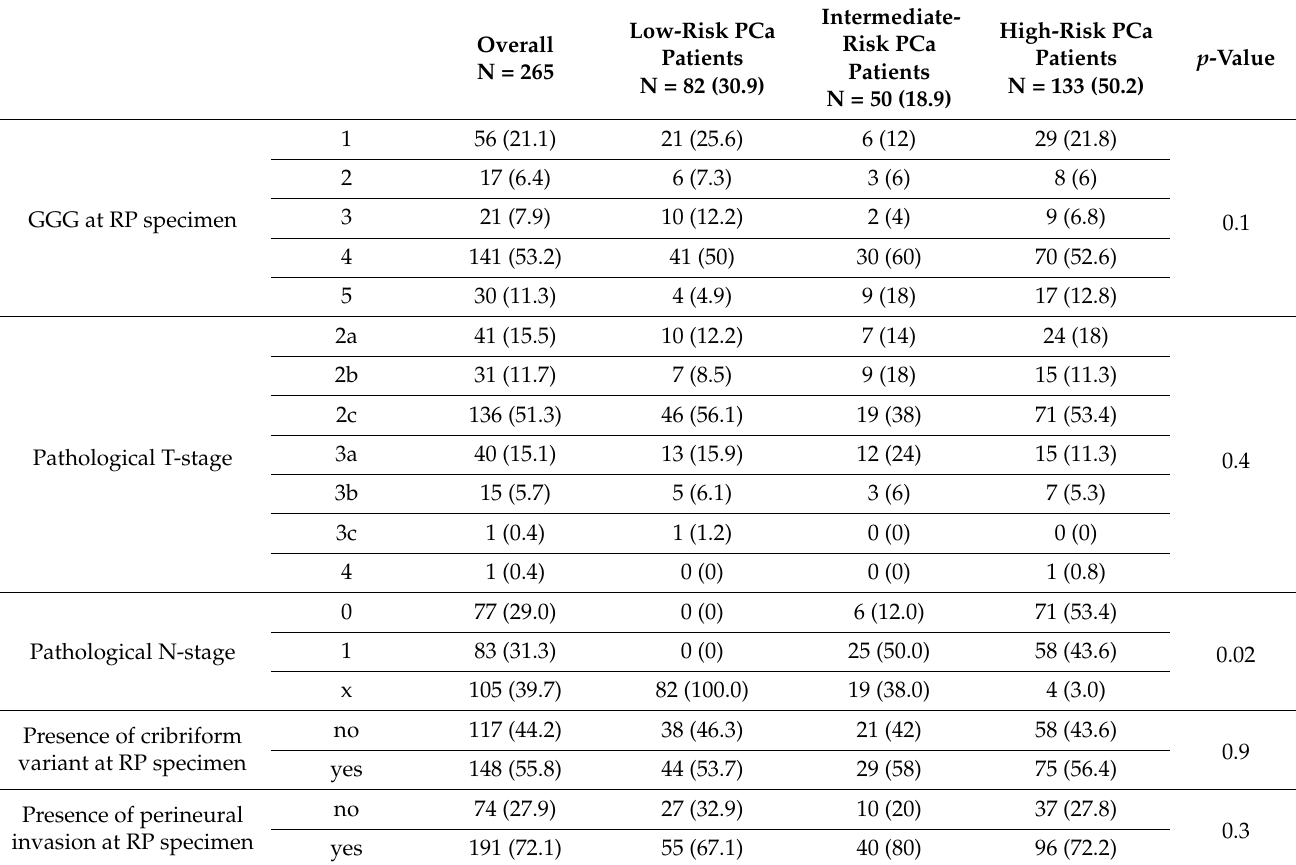
Table 2. Tumor characteristics of 265 PCa patients at RP specimen, stratified according to D’Amico risk classification. Intermediate- Low-Risk PCa High-Risk PCa Overall Risk PCa p -Value Patients Patients N = 265 Patients N = 82 (30.9) N = 133 (50.2) N = 50 (18.9)